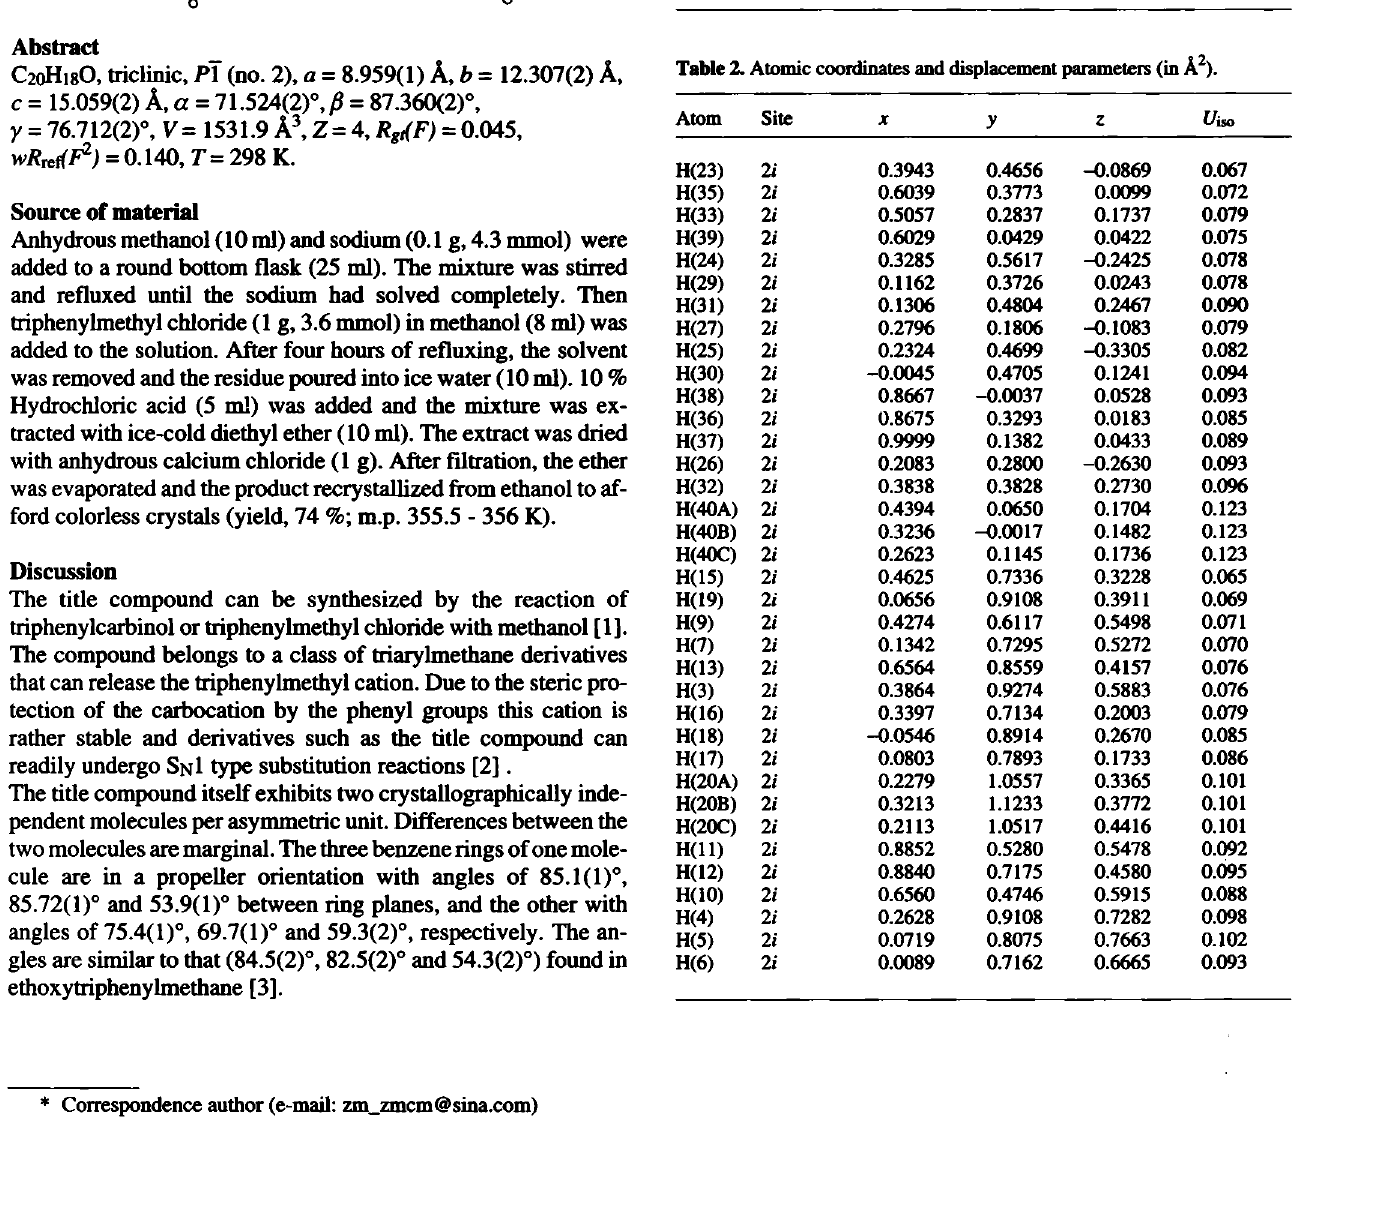
Table 2. Atomic coordinates and displacement parameters (in Â 2